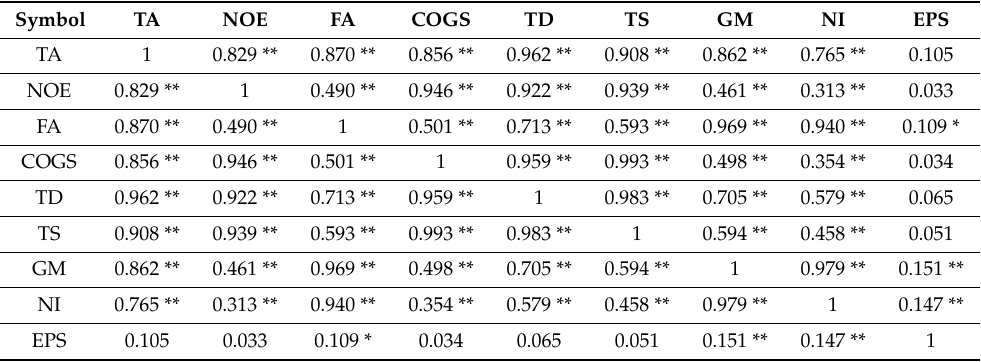
Table 2. The results of Pearson correlation.